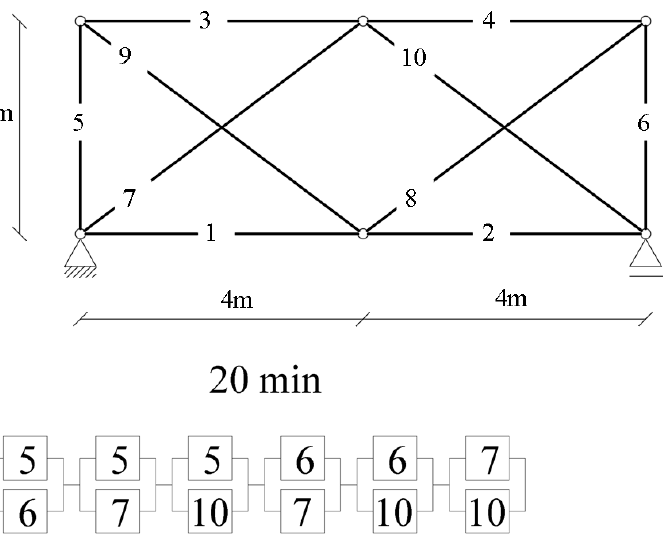
Figure 5. The reduced static scheme of the structure with two degrees of static indeterminacy and the corresponding reduced cut-sets.